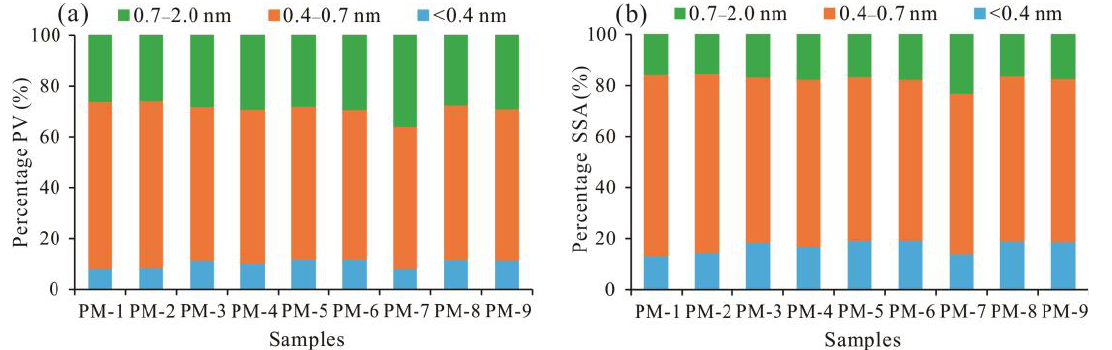
Figure 10. Distributions of different pore sizes acquired from CO 2 /N 2 adsorption in terms of the ( a ) per-centage of pore volume and ( b ) percentage of SSA.